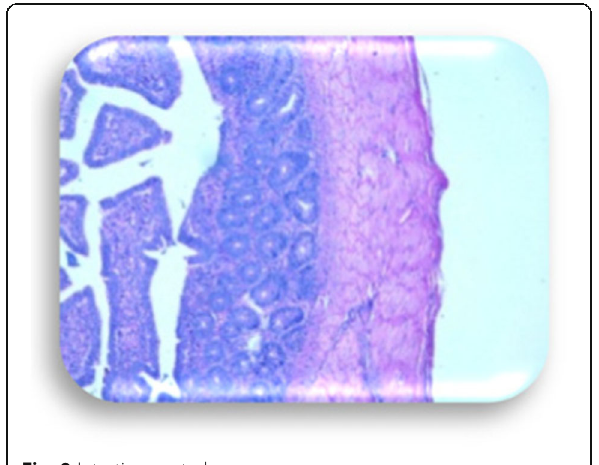
Fig. 9 Intestine control